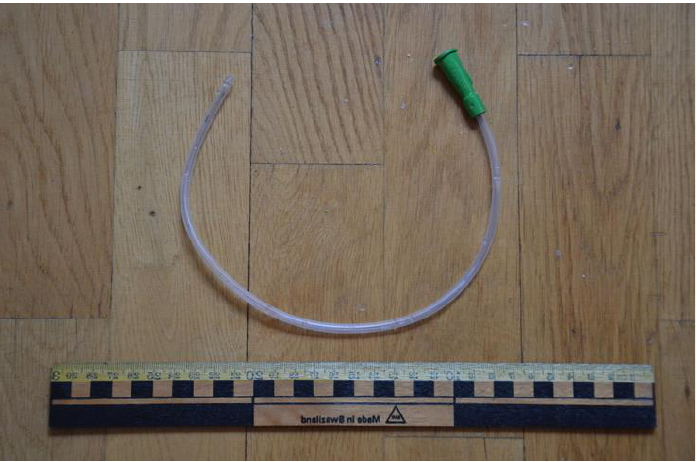
Figure 2. Intermittent catheter. Reprinted from ref. [13] under a creative common license (CC BY-SA 3.0), Originally created by Bengt Oberger.